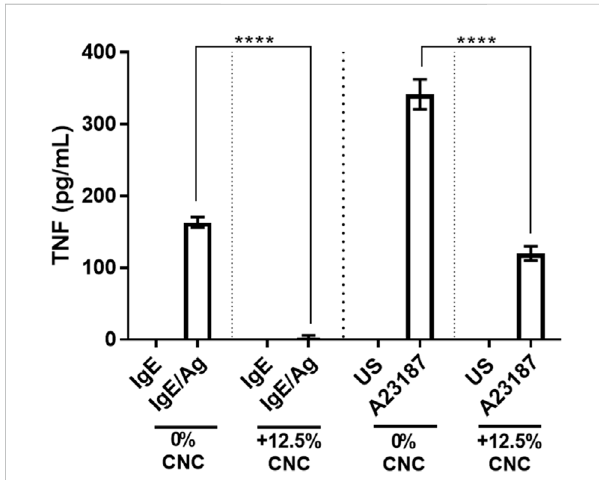
FIGURE 8 CNC/agarose matrix effect on BMMC mediator release. (A) BMMC were cultured in the absence (0)% CNC) or presence (12.5% CNC) ofCNC/agarose substrates for18 h,removedand activatedwith either IgE and antigen (Ag) where cells sensitized with IgE alone (IgE) were used as a control, or A23187 where unstimulated cells (US) were used as a control and their production of TNF was measured by ELISA. Statistical analysis was performed using One-Way ANOVA with Tukey post-hoc test relative to activated cells incubated in the absence of CNC (0% CNC), p < 0.0001 (****). Experiments were performed in triplicate with biological replicate of